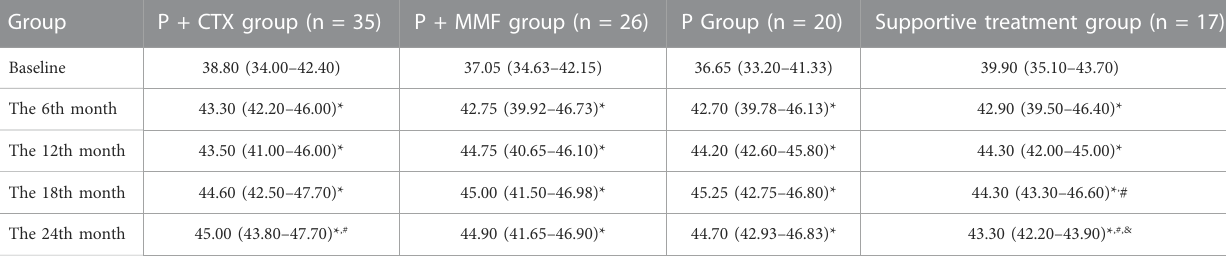
TABLE 4 Comparison of ALB in different treatment groups of severe IgAN.